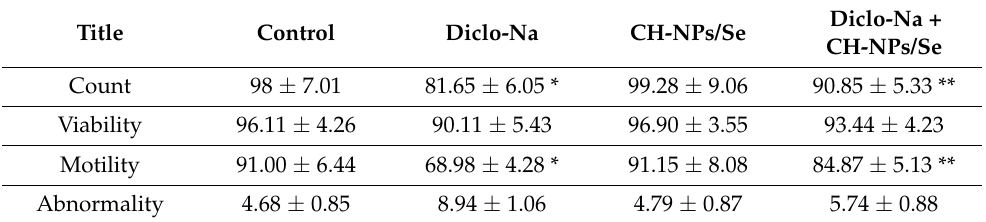
Table 3. Effect of CH-NPs/Se on sperm functional characteristics in male rats treated with